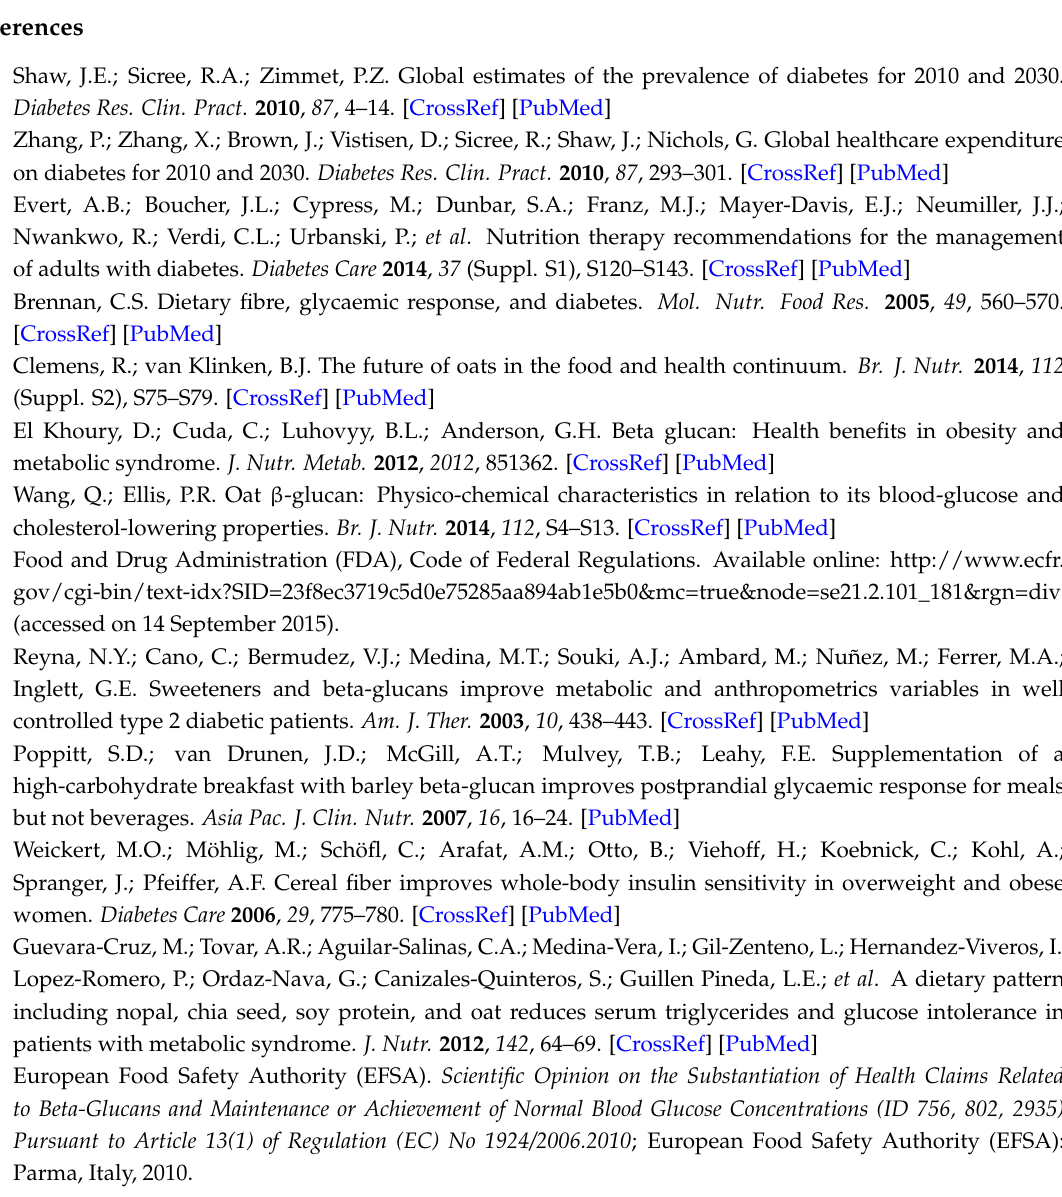
Figure S6. Results of the meta-analysis carried out to investigate the effect of oat intake on triglyceride (TG). The changes from baseline (Mean ˘ SD) between the two groups were compared. MD, mean difference; CI, confidence interval. Figure S7. Results of the meta-analysis carried out to investigate the effect of oat intake on weight. The changes from baseline (Mean ˘ SD) between the two groups were compared. MD, mean difference; CI, confidence interval. Figure S8. Results of the meta-analysis carried out to investigate the effect of oat intake on body mass index (BMI). The changes from baseline (Mean ˘ SD) between the two groups were compared. MD, mean difference; CI, confidence interval